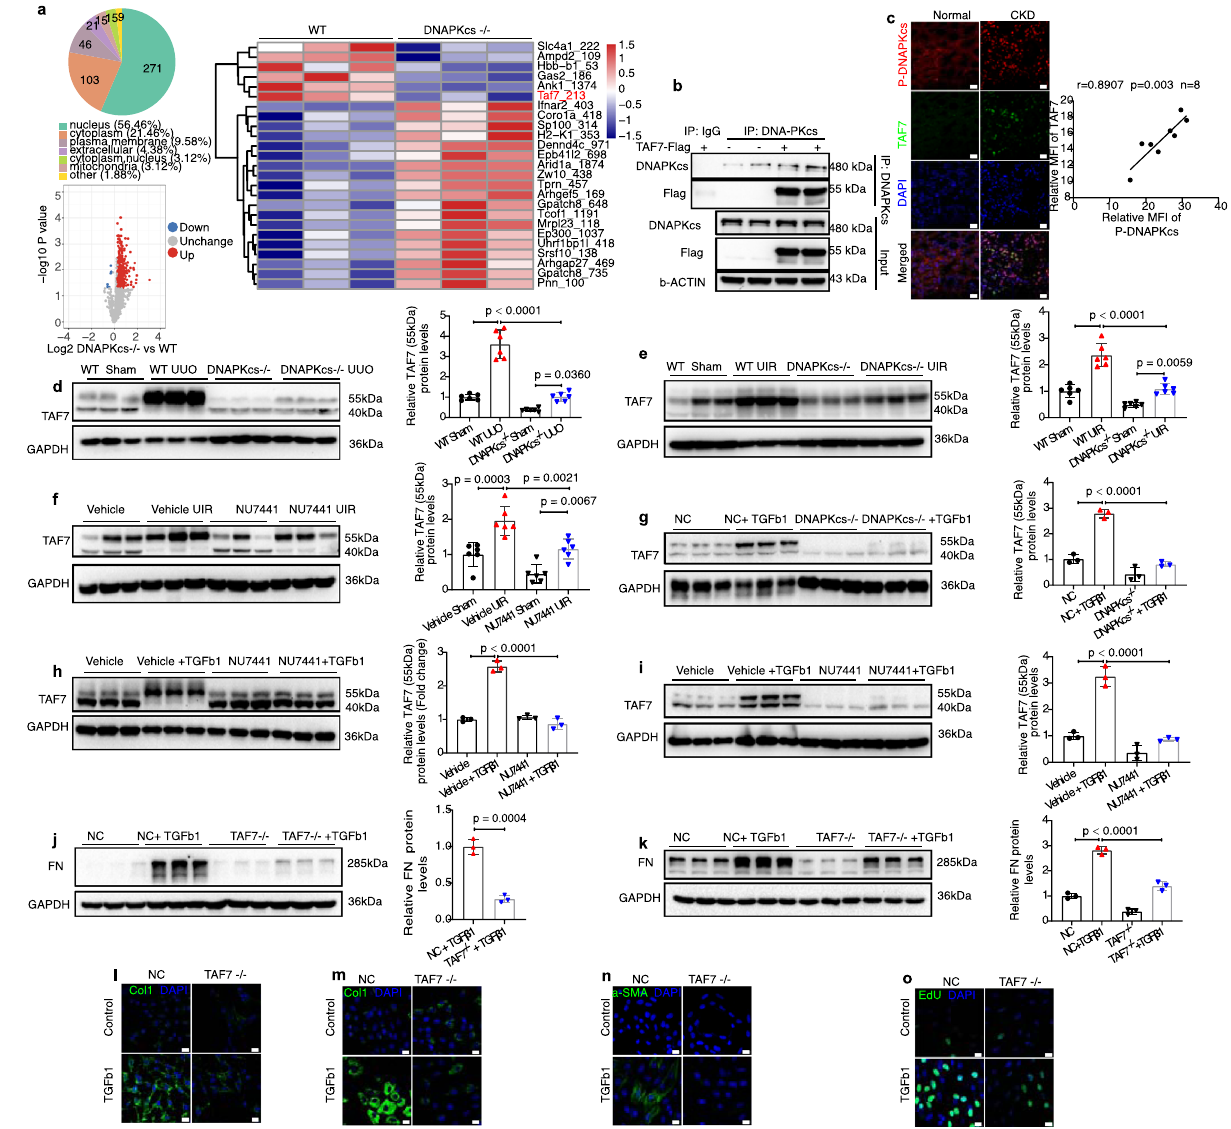
Fig.5|DNA-PKcs-mediatedphosphorylationofTAF7aggravatesrenal fi brosis. a Phosphoproteomicspro fi lingofWTandDNA-PKcs − / − kidneytissues.Differentially expressed statistical analysis, including subcellular localization, volcano plot and heat-map analysis, is shown ( n =3 mice of each group). b the interaction between Flag-tagged TAF7 and endogenous DNA-PKcs visualized by immunoprecipitation with an anti-DNA-PKcs antibody and immunoblotting with an anti-Flag antibody ( n =3 independent experiments). c Immuno fl uorescence co-staining of p-DNA- PKcswithTAF7inkidneytissuesofnormalandCKDhumanstudyparticipants,red: p-DNA-PKcs, green: TAF7, bule: DAPI, scale bars: 20 μ m. Pearson ’ s r correlation analysis between TAF7 and p-DNA-PKcs protein levels in CKD patients ( n =8) with 95%con fi denceintervalfrom0.4997to0.980. d ProteinlevelsofTAF7inDNA-PKcs − / − or WT mice subjected to UUO (day 7) or UIR (day 21) ( e ); NU7441 (40mg/kg) or vehicle treatment mice subjected to UIR ( f ), bars represent quanti fi cation results (mean±SD, n =6 mice); DNA-PKcs − / − HK-2 cells treated with TGF β 1 (5ng/ml) for